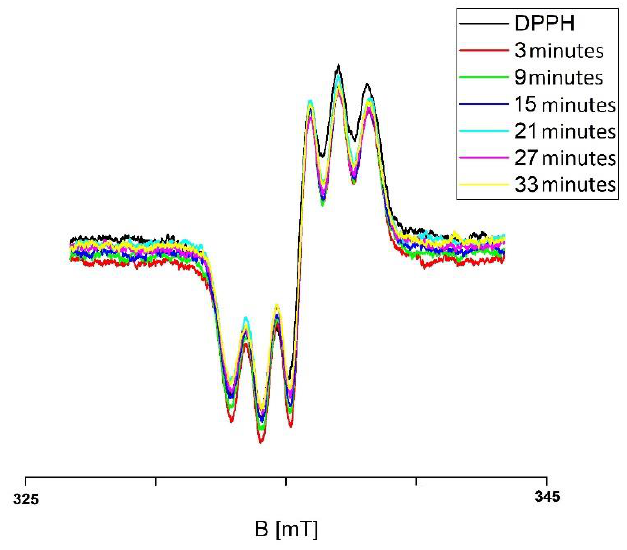
Figure 1. EPR spectra of DPPH free radicals interacting with the infusion of the root of Asparagus racemosus for 3, 9, 15, 21, 27, and 33 min. B—magnetic induction. Data for the infusion of the root of Asparagus racemosus not exposed to UV radiation.